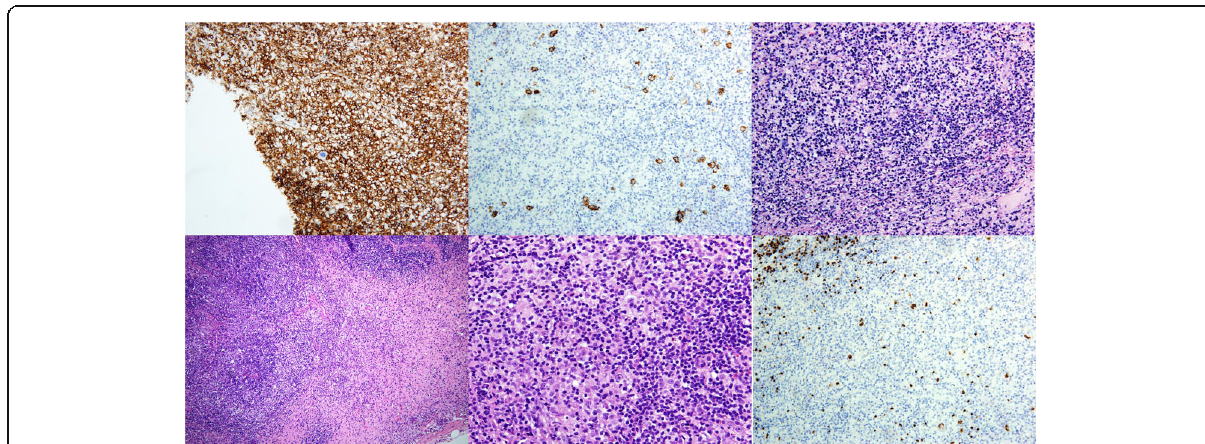
Fig. 3 Sections demonstrate atypical nodular lymphoid infiltrate separated by ill-defined fibrotic bands. The nodular lymphoid infiltrate is mainly composed of large atypical cells morphologically resembling Reed-Sternberg cells, in a mixed inflammatory background consisting of small lymphocytes, histiocytes, plasma cells, and occasional eosinophils. The large atypical cells are positive for CD30, PAX5 (dim) and negative for CD20, CD15, CD45, and CD3. CD3 stains numerous T cells in the background. EBER-ish is positive in the Hodgkin cells based on EBV stain performed on with appropriate